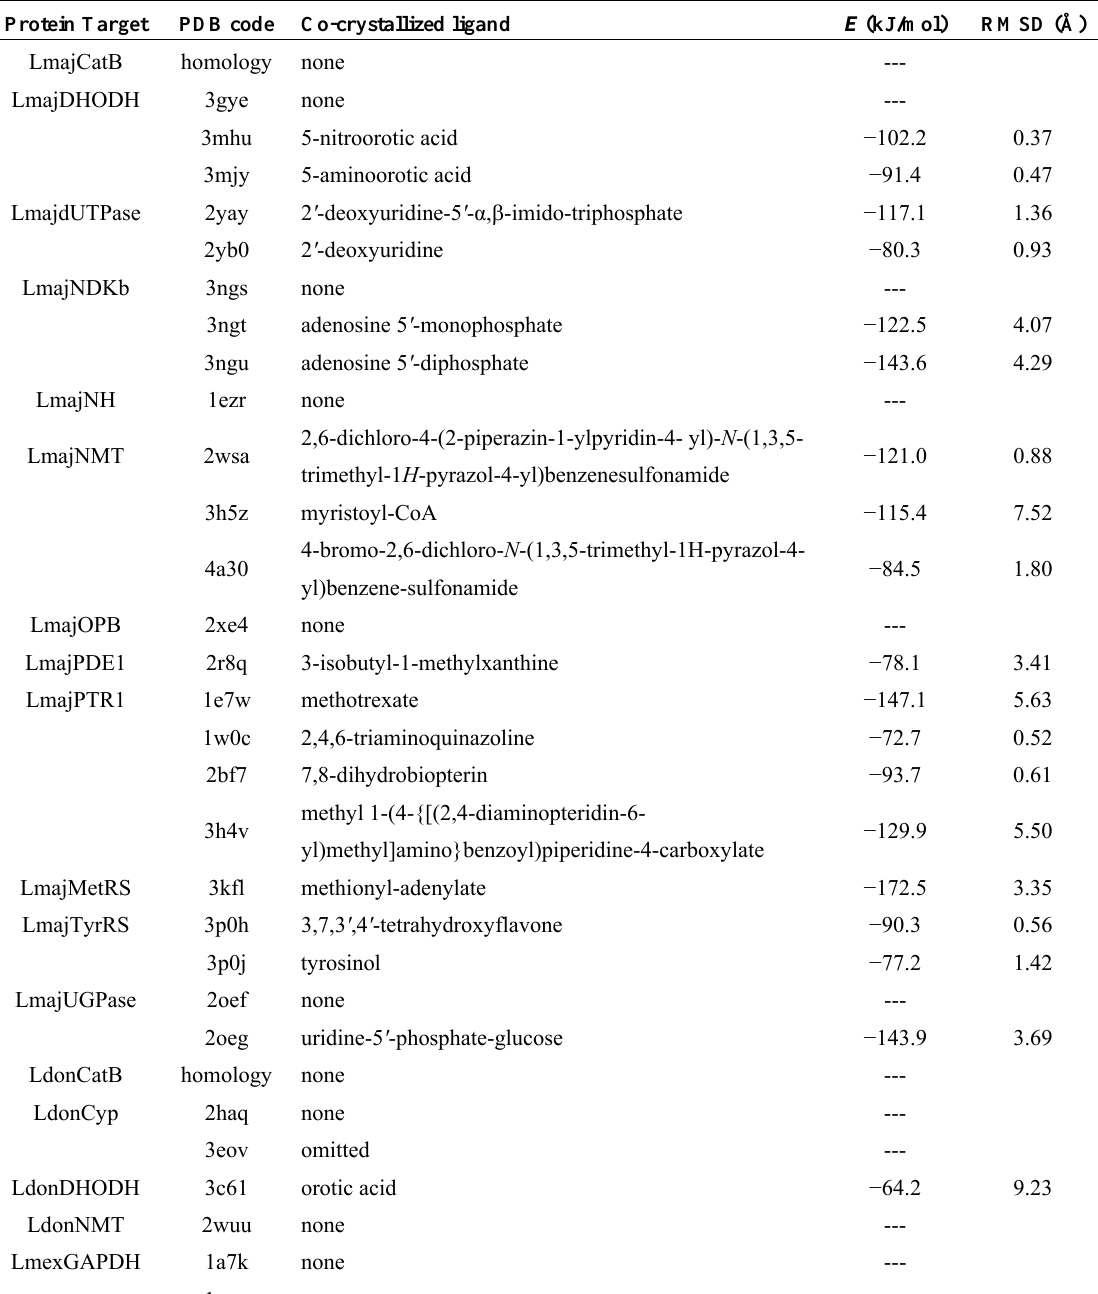
Table 41. MolDock docking energies of co-crystallized ligands and root-mean-squared deviations between the co-crystallized ligand and the re-docked poses of the co-crystallized ligand with Leishmania protein crystal